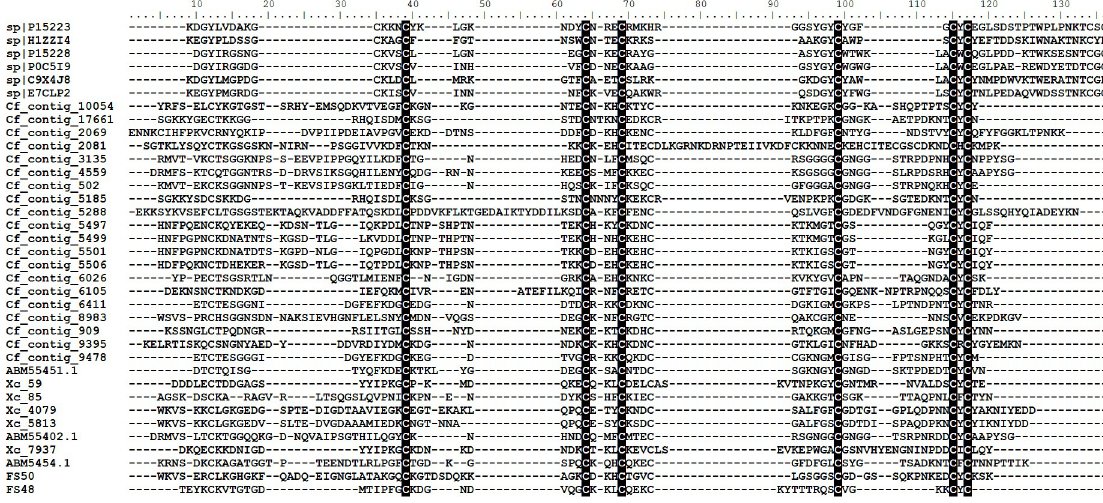
Fig 3. Amino acid alignment of C . felis cholinesterases. C . felis sequences found in the mass spectrometry analysis were aligned with sequences from Torpedo californica (1EA5), Mus musculus (1MAA), Cimex lectularius (GU597837) and the human (sp|P06276) cholinesterases. The catalytic triad residues Ser, Glu and His are